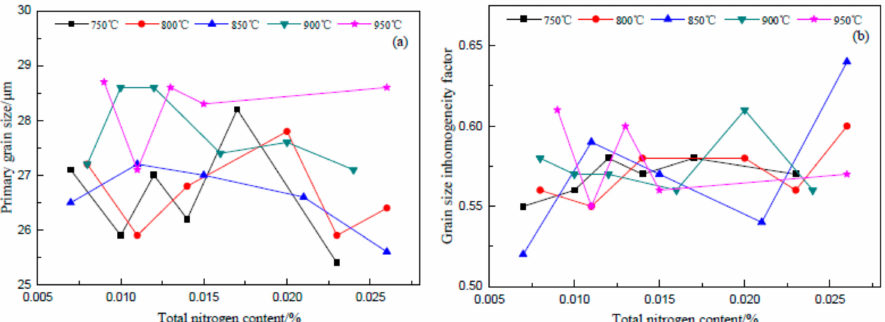
Figure 1. Relation between total nitrogen content and primary grain size ( a ), and the grain size inhomogeneity factor ( b ) of a decarburized sheet after nitriding annealing from 750 ◦ C to 950 ◦